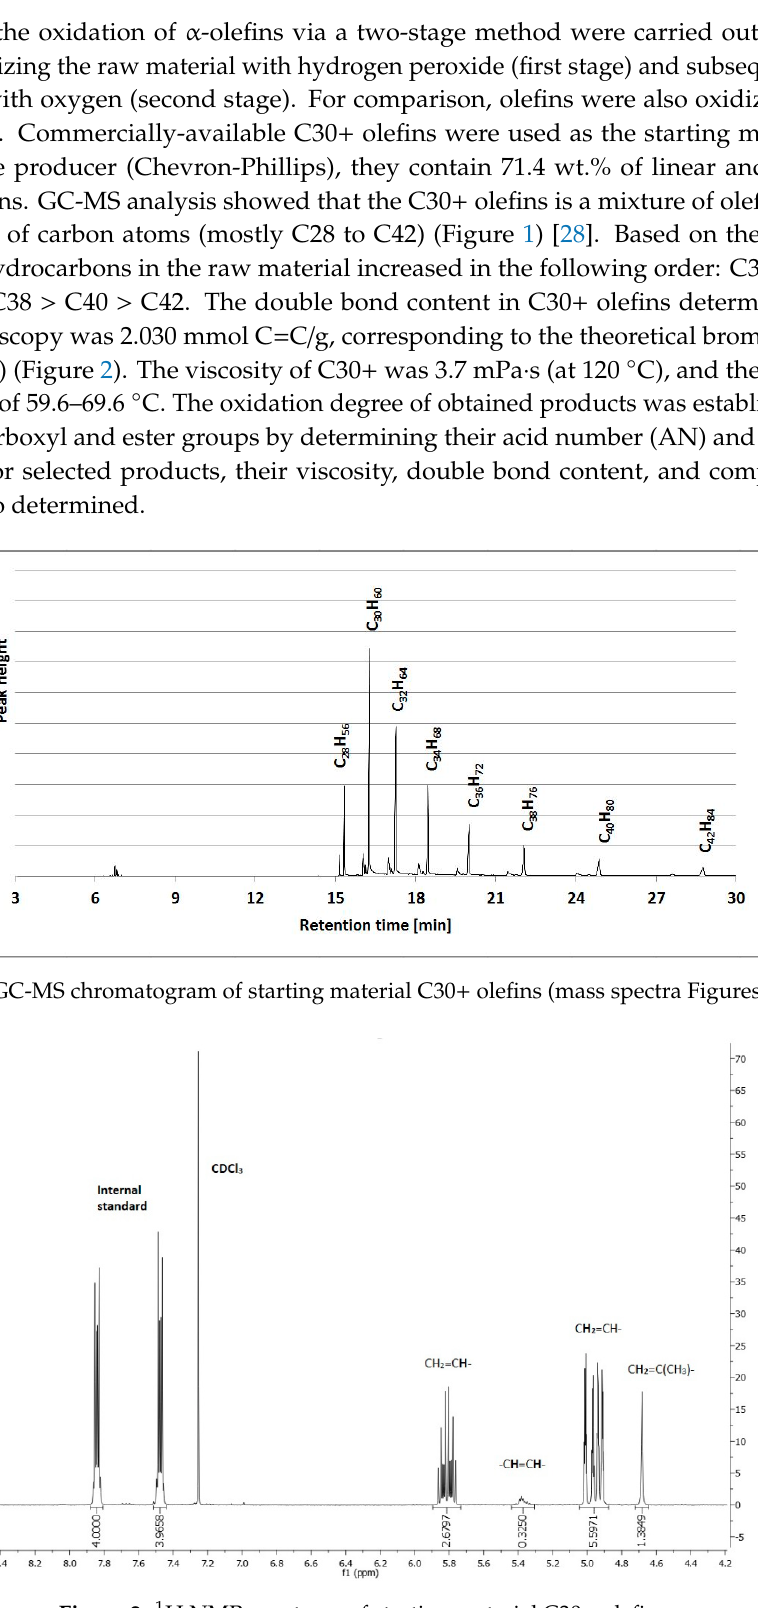
Figure 2. 1 H NMR spectrum of starting material C30+ olefins.